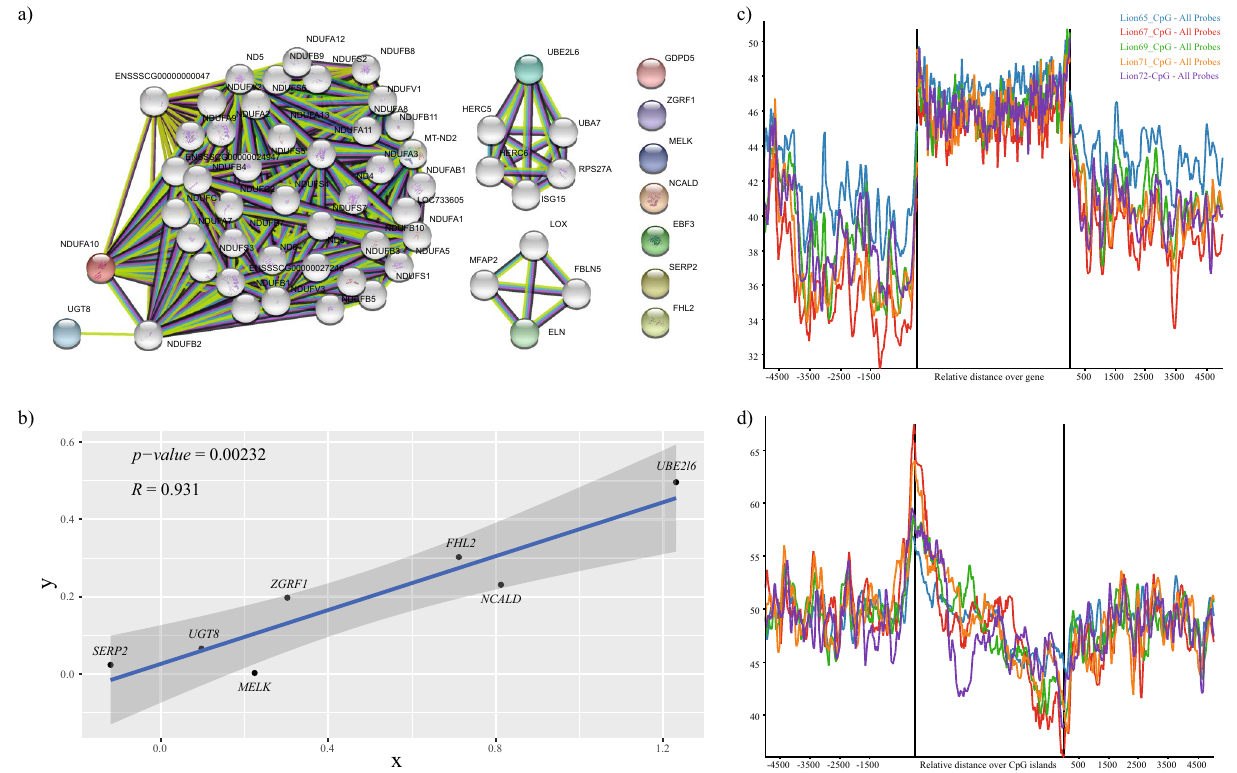
Figure 4. Related protein association and validation was performed. ( a ) All the identified genes were visualized using string database. ( b ) RT-PCR result for randomly selected genes showing high correlation and significant p-value or r = 0.931 and p-value = 0.00232. ( c , d ) Methylation pattern where a relative degree of gene stabilization can be seen and ( d ) sharply decreasing at TSS region of CpG island and stabilizing